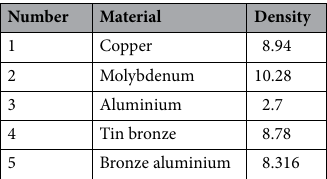
Table 6. The COTS materials used in the optimization process of manufactured radiation shields.